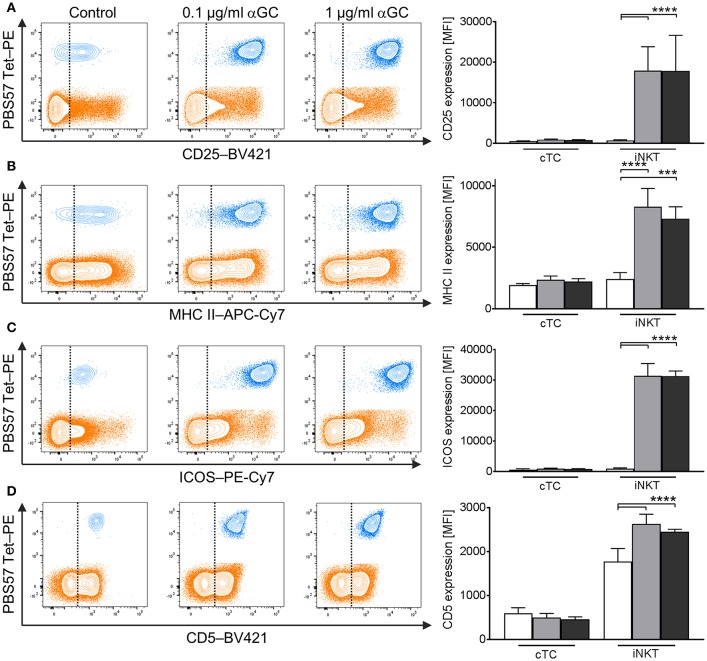
Changes in surface marker expression on porcine iNKT cells upon antigenic activation. Porcine PBMC were incubated in the presence of 0.1 μg/ml or 1 μg/ml αGC or DMSO as vehicle control for 4 days. Representative flow cytometric plots showing expression of (A) CD25, (B) MHC II, (C) ICOS, and (D) CD5 on cTC (orange) and iNKT cells (blue). Expression level of control cells (white) and cells stimulated with 0.1 μg/ml (gray) and 1 μg/ml αGC (black) are shown (n = 3-4). Dotted lines show threshold according to marker expression by cTC. Data shown as mean (SD), ***p < 0.001, ****p < 0.0001, repeated-measures one-way ANOVA with Holm-Sidak's post-hoc test for multiple comparisons.